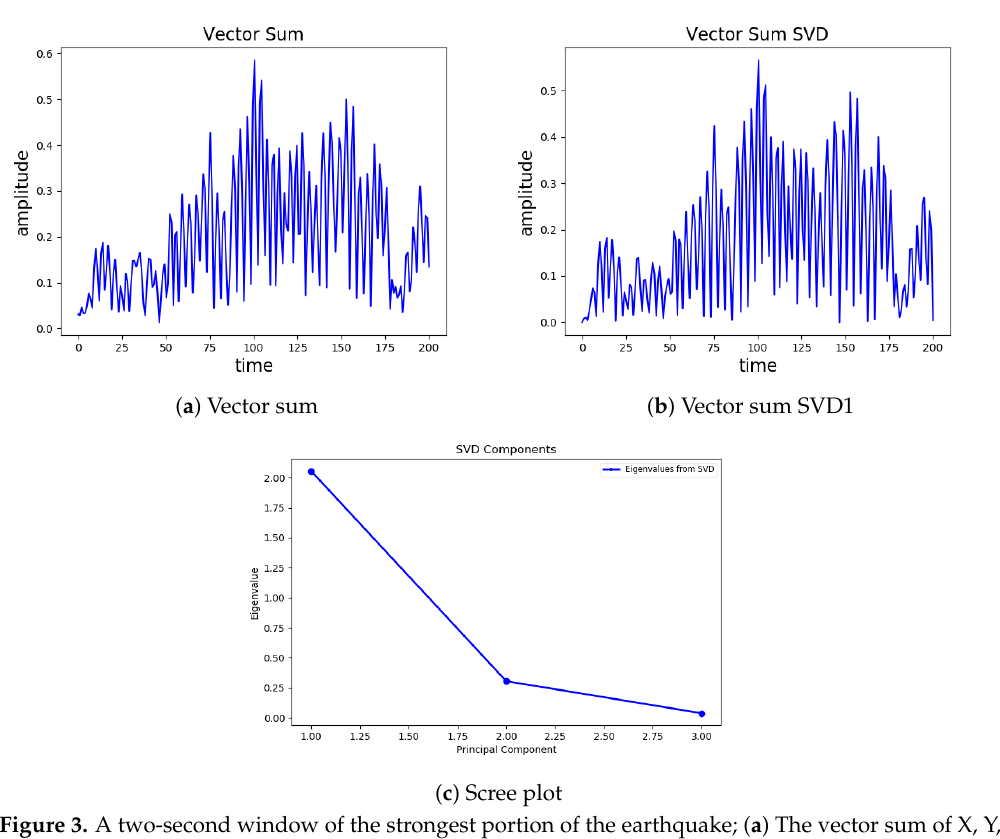
Figure 3. A two-second window of the strongest portion of the earthquake; ( a ) The vector sum of X, Y, and Z; ( b ) vector sum of the primary vector of SVD (center); ( c ) scree plot of the three components.